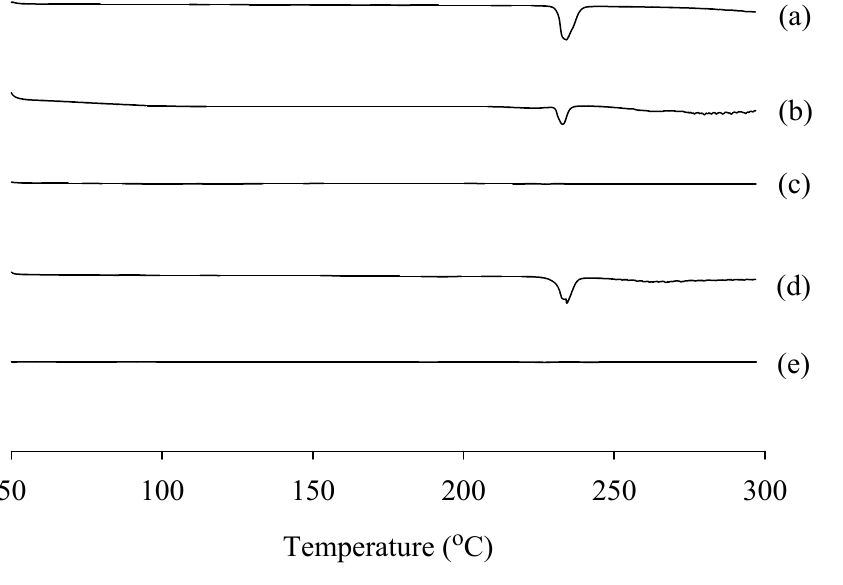
Figure 6. Comparison of differential scanning calorimetric thermograms: (a) RXB powder; (b) physical mixture of RXB and gelatin (1:5); (c) gelatin-based solid dispersions (1:5); (d) physical mixture of RXB and PVA (1:0.5); (e) PVA-based solid dispersions (1:0.5).